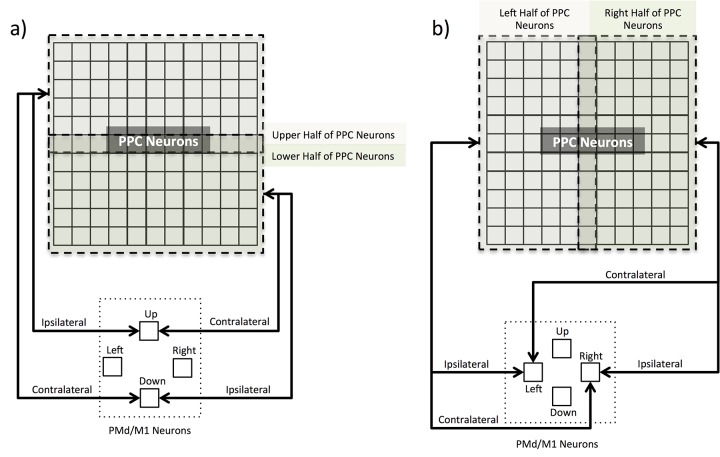
Ipsilateral and Contralateral Connections between PPC and PMd/M1.The images illustrate the difference between ipsilateral and contralateral connections between the PPC and PMd/M1 neurons. The 121 PPC neurons are arranged in a 2-D array (11x11) to illuminate the upper vs. lower and left vs. right halves of PPC neurons connecting to the 4 PMd/M1 neurons. Ipsilateral indicates the half of PPC neurons connected to the corresponding PMd/M1 neuron (e.g., Upper half of PPC neurons to the Up PMd/M1 neuron). Contralateral indicates the half of PPC neurons connected to the opposite PMd/M1 neuron (e.g., Upper half of PPC neurons to the Down PMd/M1 neuron). The ipsilateral and contralateral connections only apply to the feedforward (PPC to PMd/M1 arrows into PMd/M1 neurons) and feedback (PMd/M1 to PPC arrows into PPC neurons) connection sets. a) Ipsilateral and Contralateral connections between the Upper/Lower half of PPC neurons and the Up/Down PMd/M1 neuron. b) Ipsilateral and Contralateral connections between the Left/Right half of PPC neurons and the Left/Right PMd/M1 neuron.